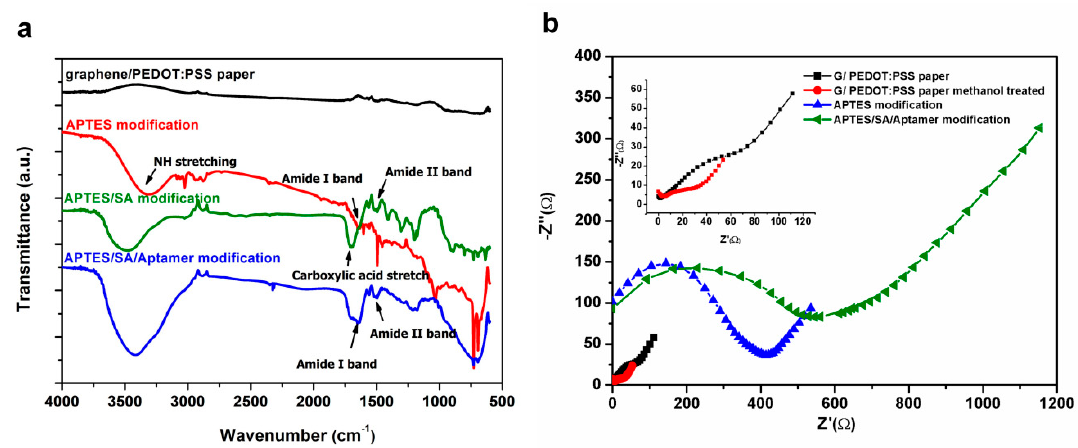
Figure 3. ( a ) The Fourier transform infrared (FTIR) spectra of a graphene/PEDOT:PSS paper electrode and (3-Aminopropyl)triethoxysilane (APTES) modified, APTES/SA modified and APTES/SA/Aptamer modified graphene/PEDOT:PSS paper electrode and ( b ) The electrochemical impedance spectroscopy (EIS) signal of graphene/PEDOT:PSS paper electrode in different surface functionalization steps.